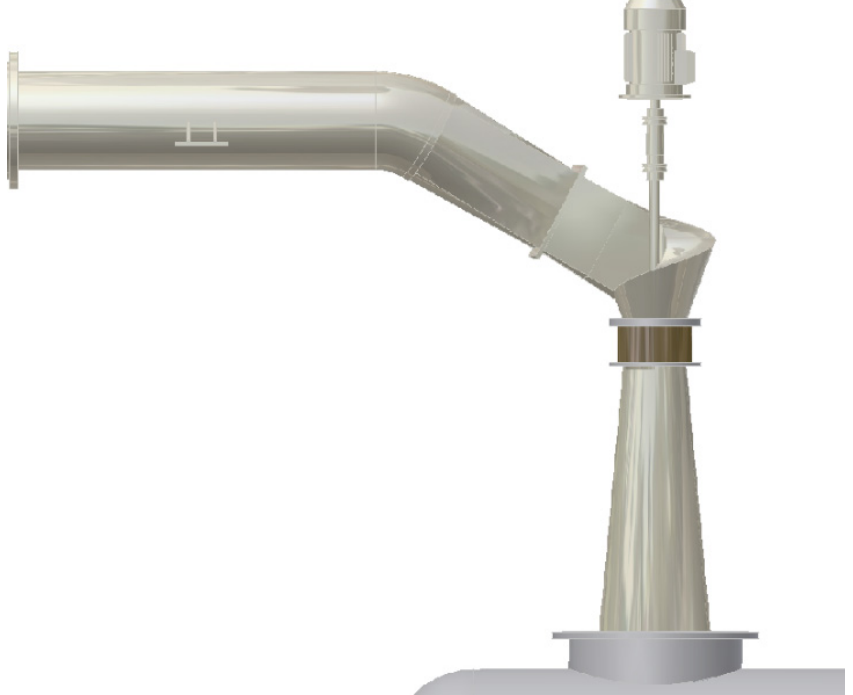
Figure 5. Model of a semi-Kaplan hydraulic turbine with a non-classical spiral inflow of water onto the runner.